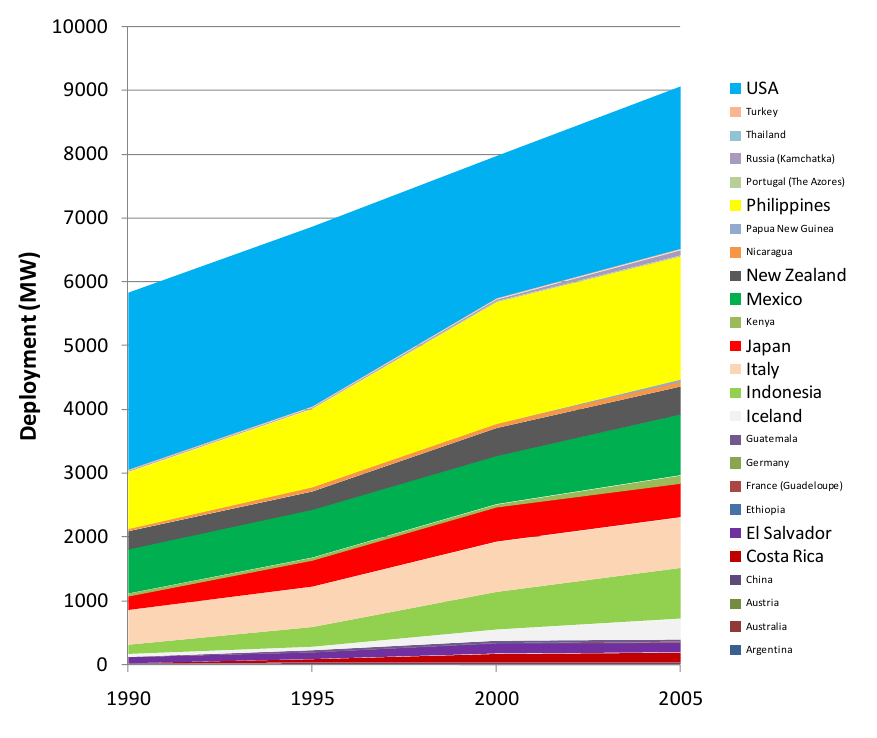
Figure 71. Deployment of geothermal power (derived from data in